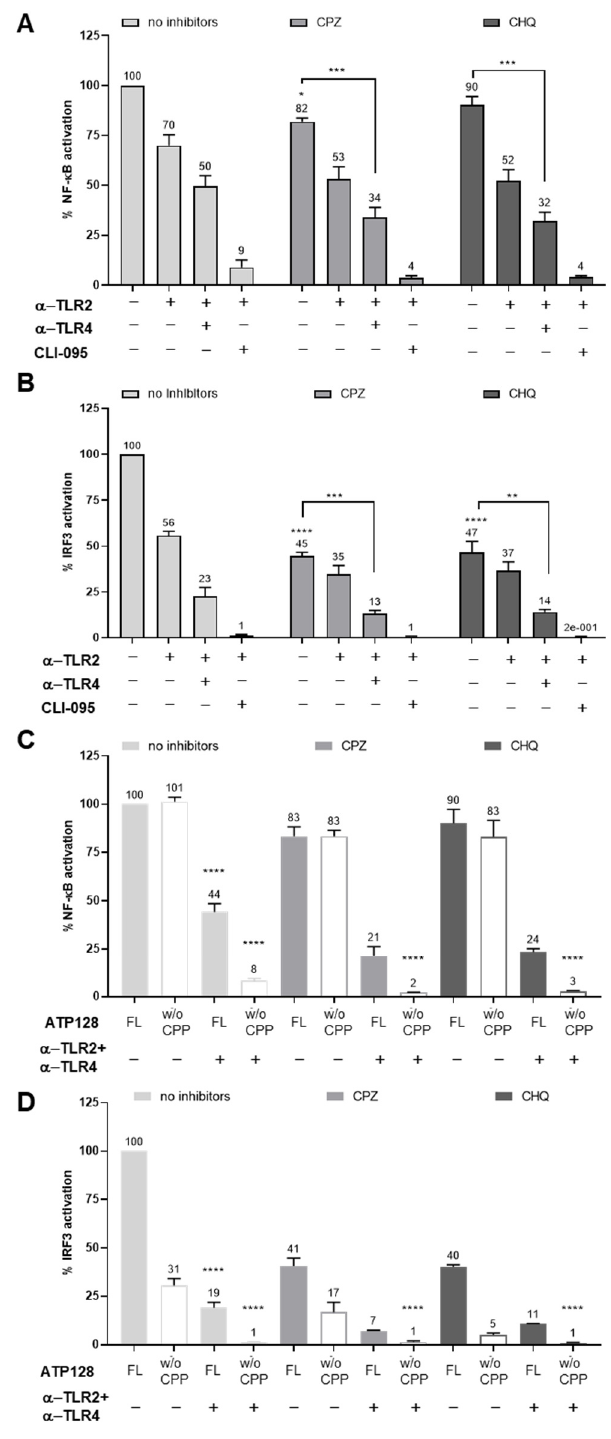
Figure 2. Characterization of the intracellular NF- κ B pathway. ( A , B ) THP-1 Dual cells were pretreated with endocytosis inhibitors, such as chlorpromazine (CPZ) to inhibit clathrin-mediated en- docytosis or chloroquine (CHQ), an inhibitor of endosomal maturation, in the presence or not of